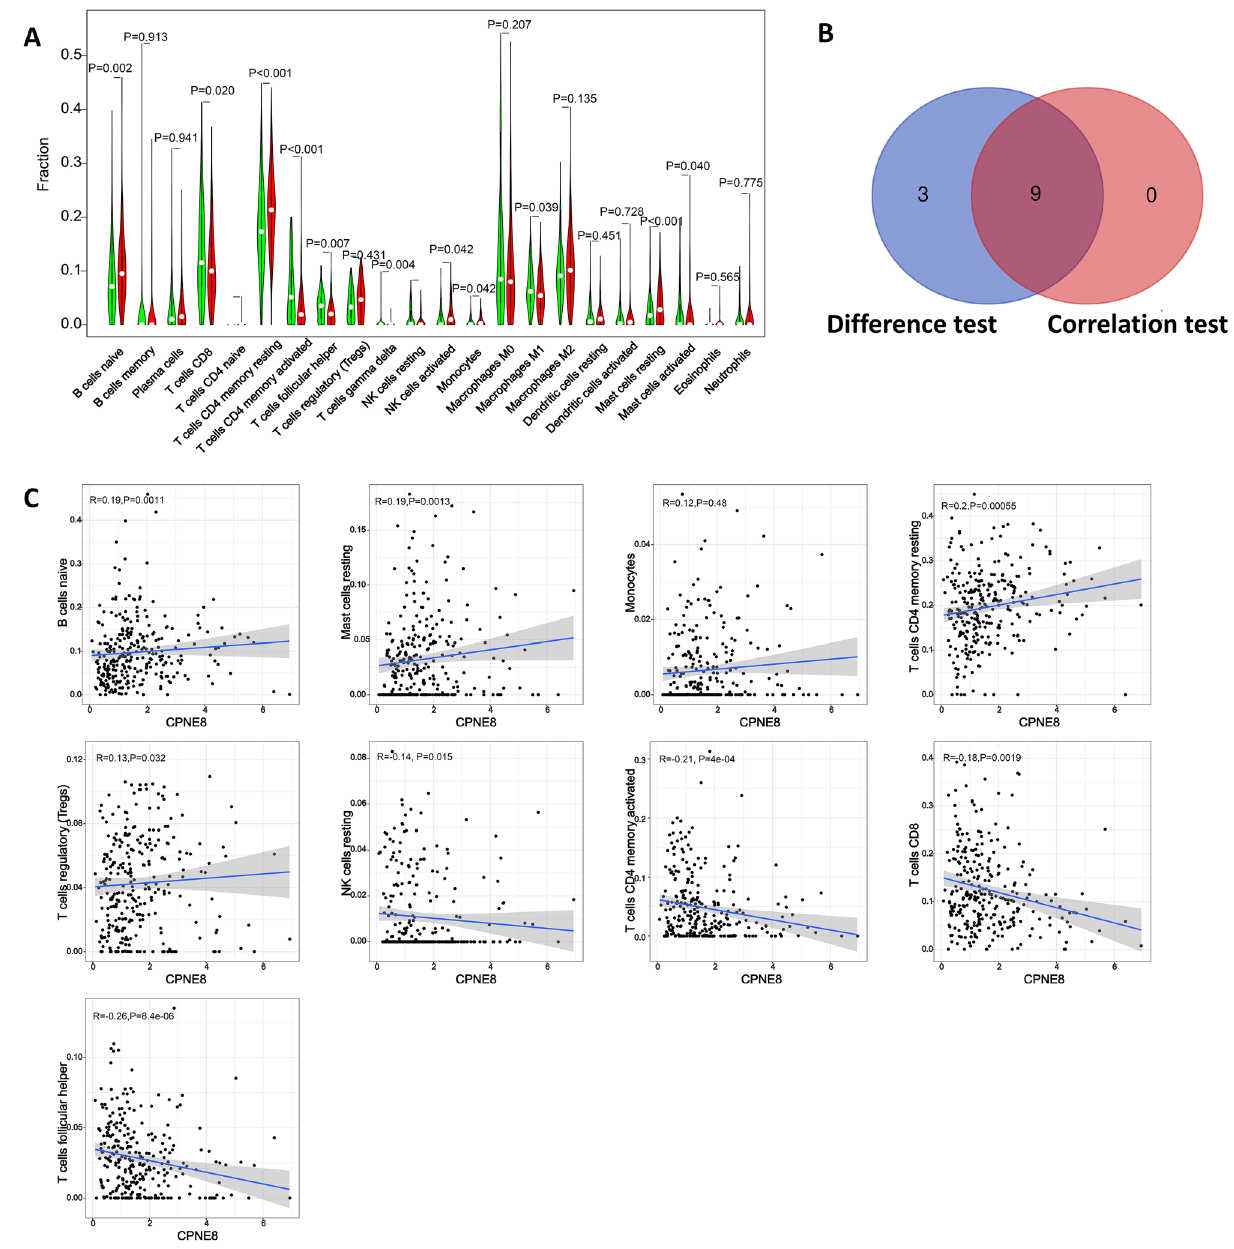
Figure 4. The association between the proportion of tumor immune cells and CPNE8 expression. ( A ) Violin plots present the ratio differentiation of 22 immune cells between gastric cancer tumor samples with CPNE8 expression. ( B ) Venn diagram showing immune cells with significant differences and correlations with CPNE8 expression. ( C ) Scatter plots show that the proportion of immune cells was correlated with CPNE8 expression (P <